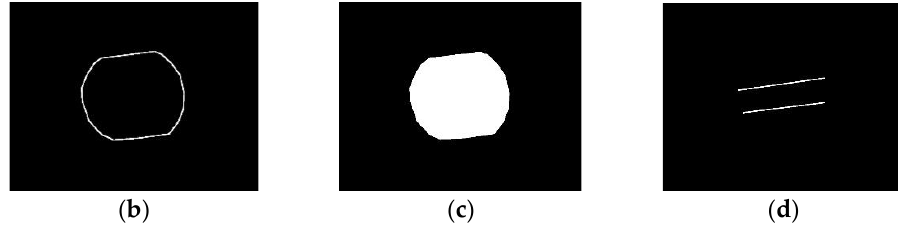
Figure 7. Different labels during training: ( a ) image; ( b ) edge label; ( c ) mask label; ( d ) line label.